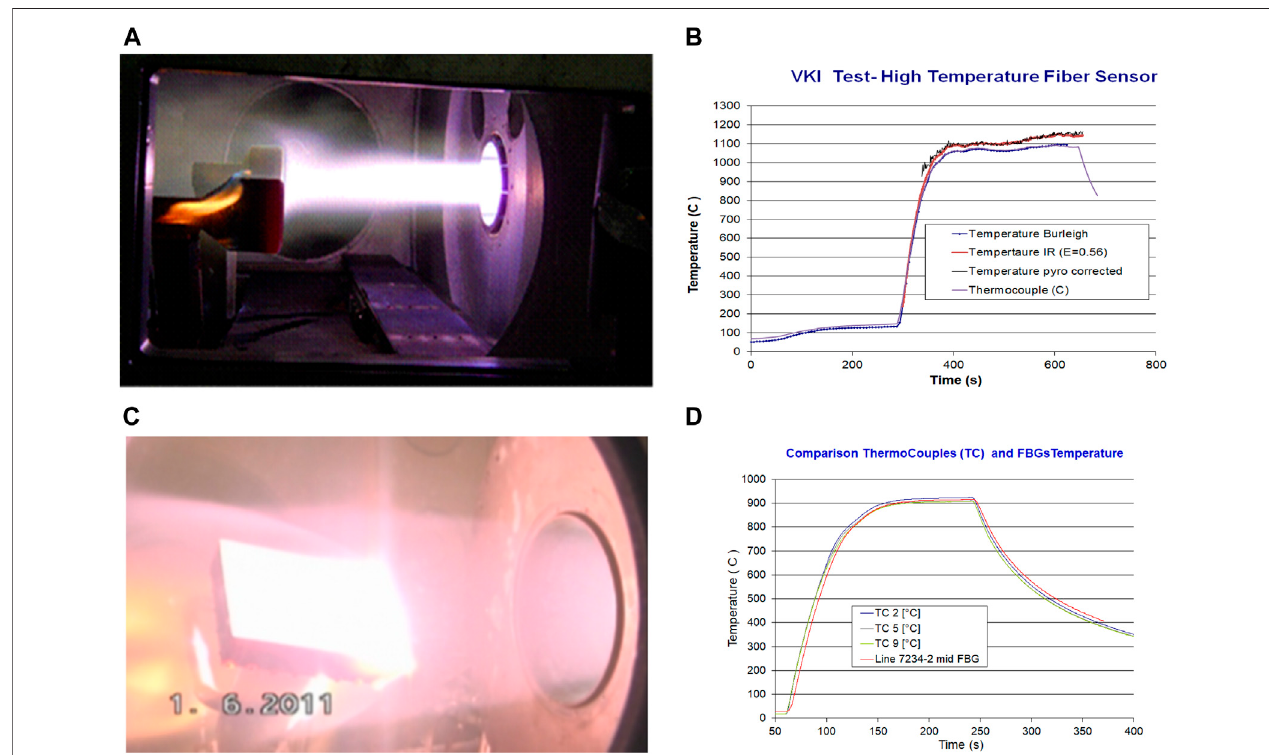
FIGURE 9 | (A) Photograph of the Plasma hitting the center of the probe with the FBG (VKI), (B) Comparison of the plasma temperature as measured by the fi ber sensors (Burleigh), Thermocouple Pyrometer and IR camera (VKI), (C) Picture of the C-SiC plate with the Fibers and Thermocouples during the Wind Tunnel test at DLR (DLR), (D) Temperature measured by one FBG and close by Thermocouples during the Wind Tunnel test (DLR).